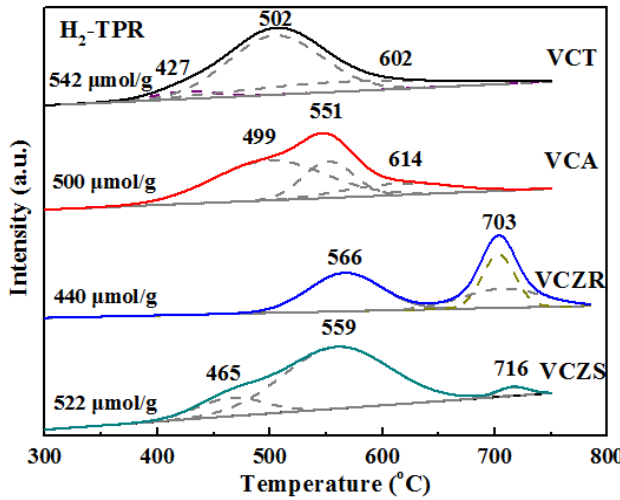
Figure 6. Temperature-programmed reduction with H 2 (H 2 -TPR) profiles of different samples.